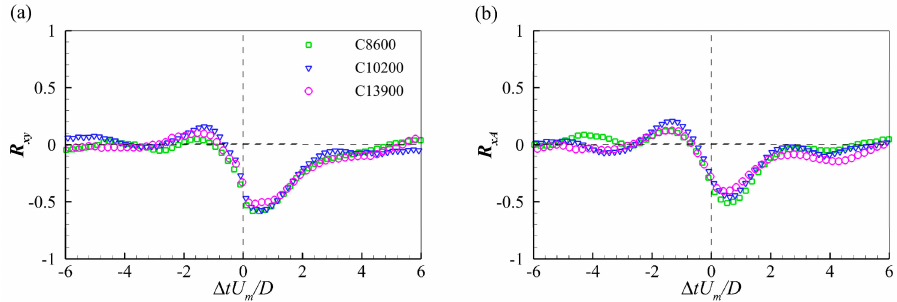
Figure 8. Correlation functions of ( a ) streamwise and vertical positions, ( b ) streamwise position and core area.